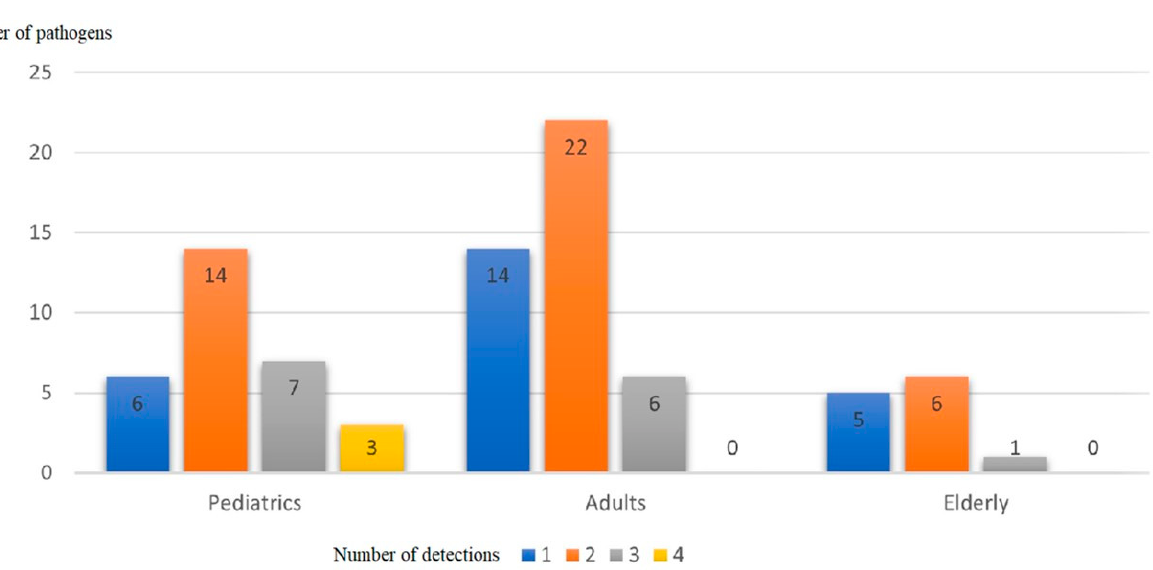
Figure 2. Distribution of viral and bacterial infections in different age groups. The highest number of pathogens was observed between December and March. RSV accounted for 2% of the cases, and was only detected in paediatric patients. The number of any pathogen detected was almost similar between the adult, geriatric, and paediatric groups (Figure 3).